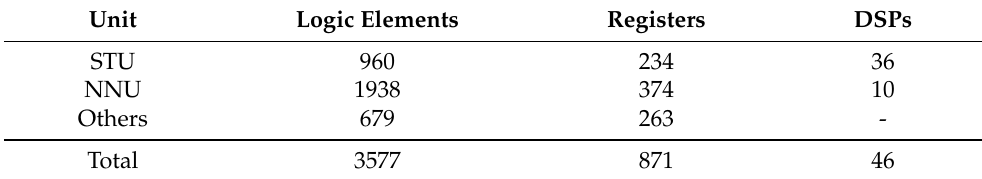
Table 4. Implementation results of the proposed HGR